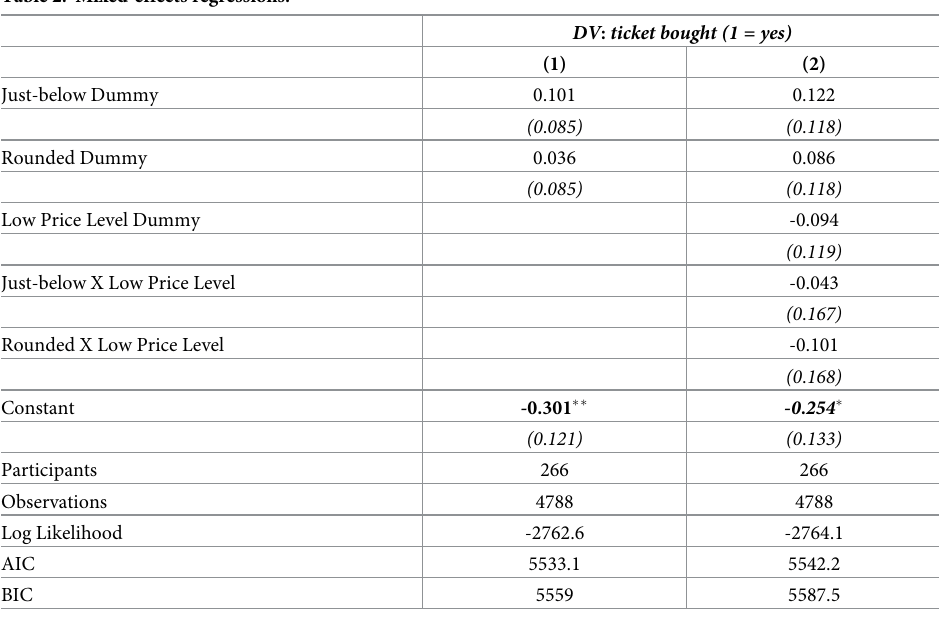
Table 2. Mixed-effects